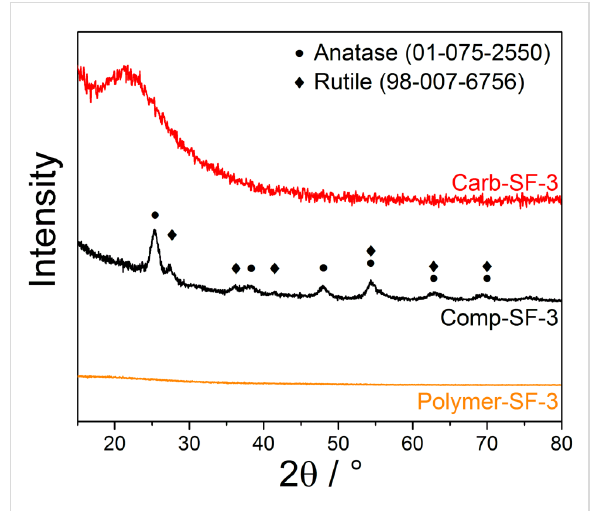
Figure 4: XRD-pattern of the polymeric precursor (Polymer-SF-3, orange), the carbonized composite (Comp-SF-3, black) and the car- bon received by chlorine treatment (Carb-SF-3,